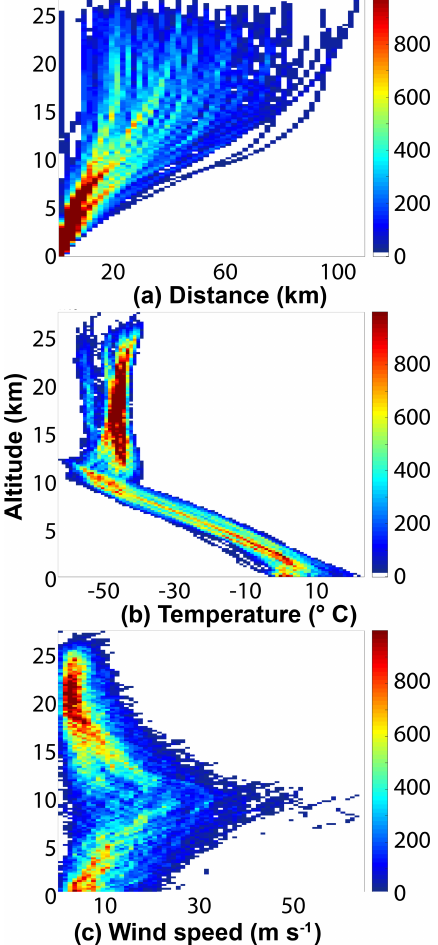
Figure 9. Two-dimensional histograms of radiosonde temperature (a) , wind speed (b) , and distance from Oliktok Point (c) , with alti- tude during